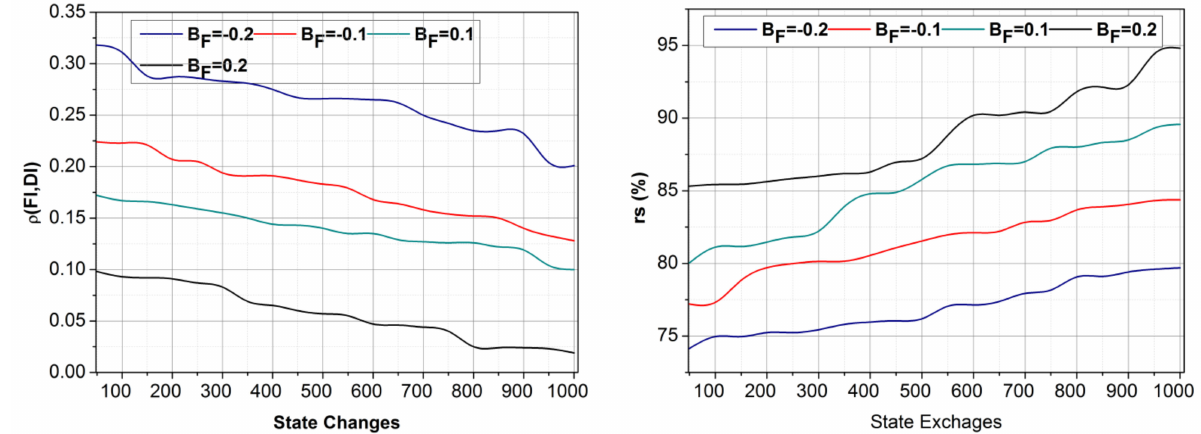
Figure 7. ρ ( Fl , Dl ) and rs (%) analysis.